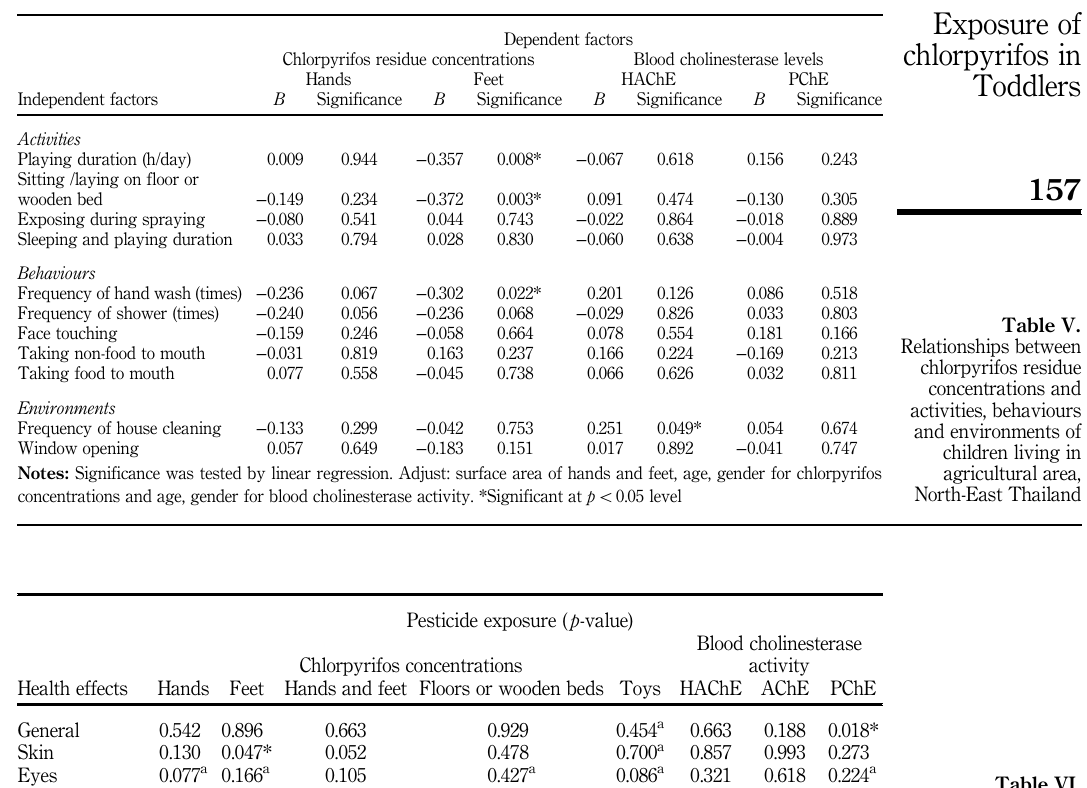
Table VI. Relationships